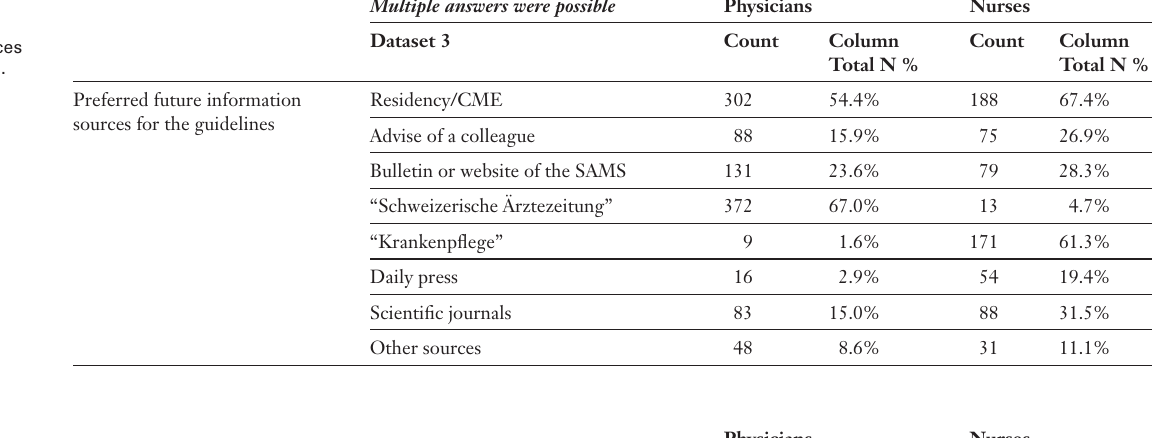
Multiple answers were possible